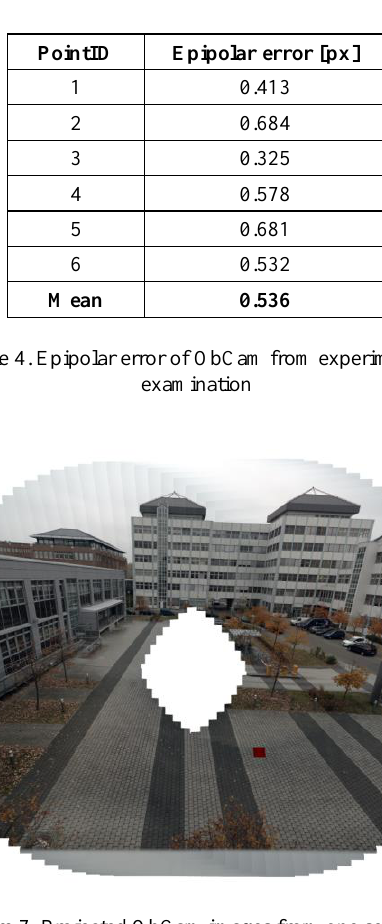
Figure 7. Projected ObCam images from one series of measurements